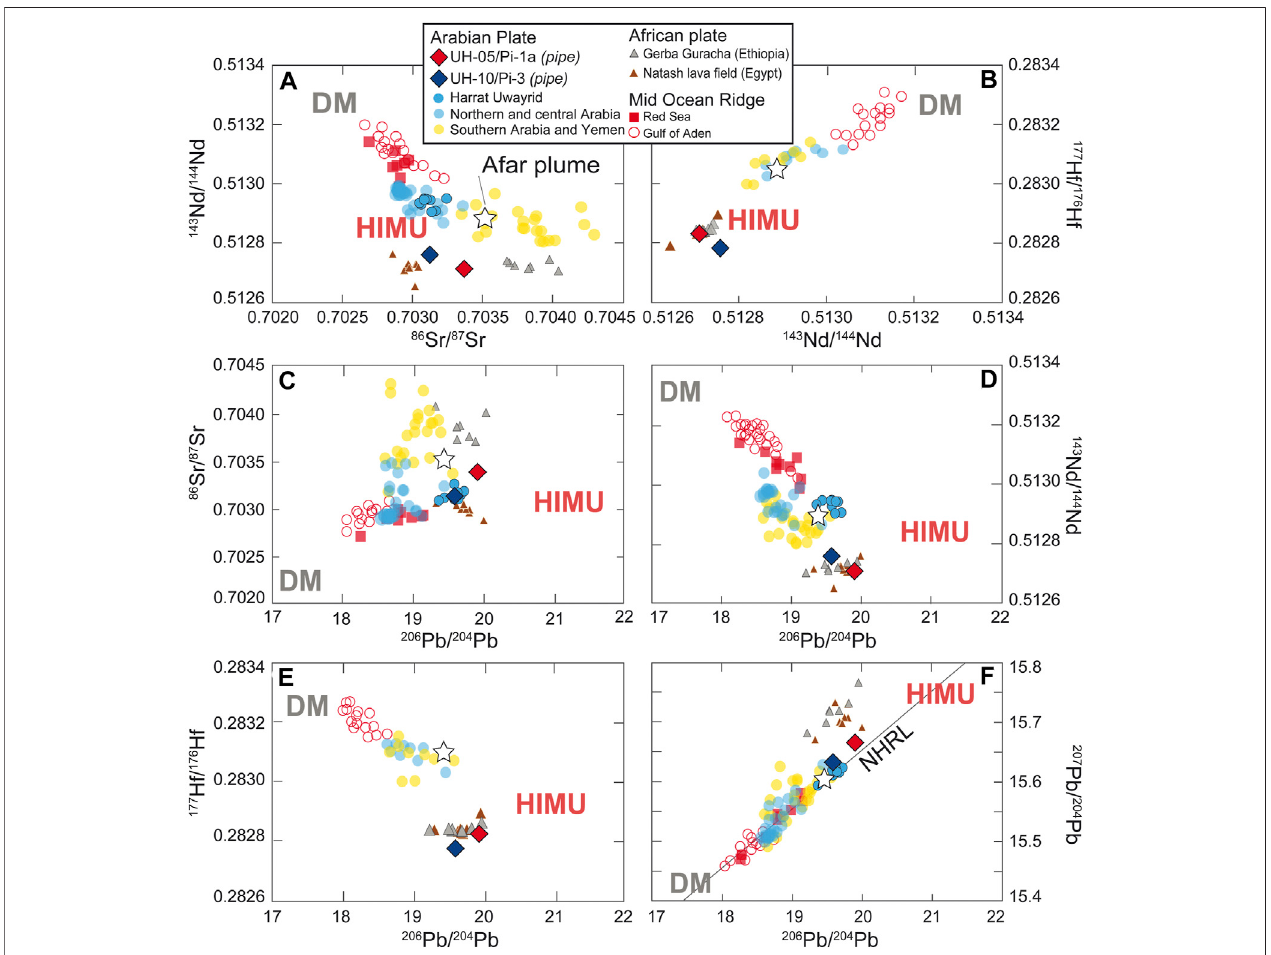
FIGURE7 | Initial Nd-Sr-Pb-Hf isotopic ratios ofbasalts from Harrat Uwayrid(data from Altherr et al., 2019) and Marthoum volcanic pipes (this study) compared to those of other lava fi elds from central and southern Arabia. Variations of 143 Nd/ 144 Nd versus 87 Sr/ 86 Sr (A) , 177 Hf/ 176 Hf versus 143 Nd/ 144 Nd (B) , 87 Sr/ 86 Sr versus 206 Pb/ 204 Pb (C) , 143 Nd/ 144 Nd versus 206 Pb/ 204 Pb (D) , 177 Hf/ 176 Hf versus 206 Pb/ 204 Pb (E) , and 207 Pb/ 204 Pb versus 206 Pb/ 204 Pb (F) . Data for central Saudi Arabian volcanic fi elds (Harrat Rahat, Harrat Khaybar, Harrat Lunayyir, Harrat Kurama, Harrat Kishb, Harrat Tu fi l) were taken from Bertrand et al. (2003) and Moufti et al. (2012), for YemenfromVolkeretal.(1997)andBertrandetal.(2003).MORBfortheRedSeaaxialtroughandGulfofAdenarefromSchillingetal.(1992),Volkeretal.(1993),Volker et al. (1997), and Haase et al. (2000), respectively. The compositions of lava fi elds from East Africa retaining HIMU-like isotopic compositions (from Rooney et al., 2014; Abu El-Rus et al., 2018) are also reported for comparison.